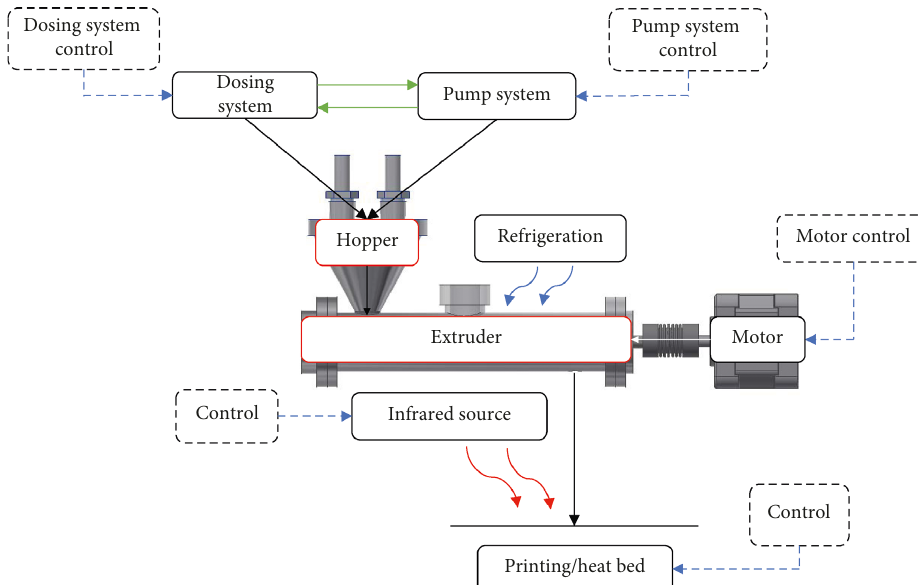
Figure 2: Overview of the entire 3D printing system.